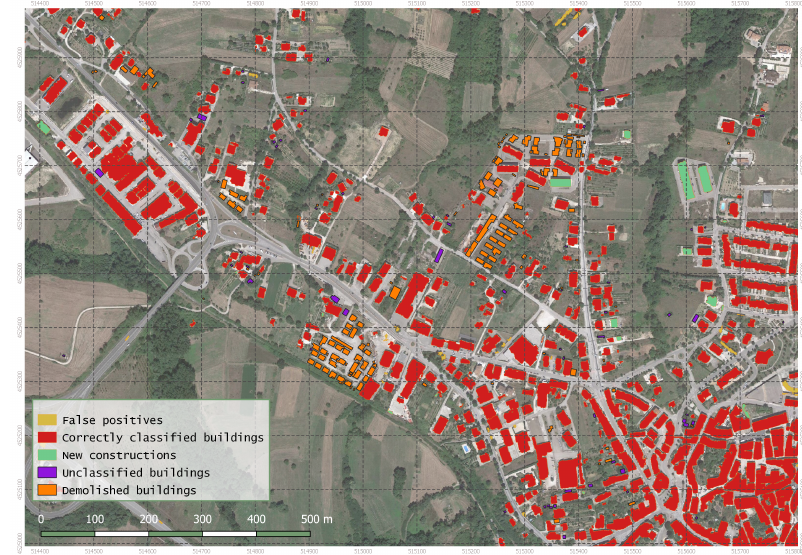
Figure 11. Example of updated municipal map and database.